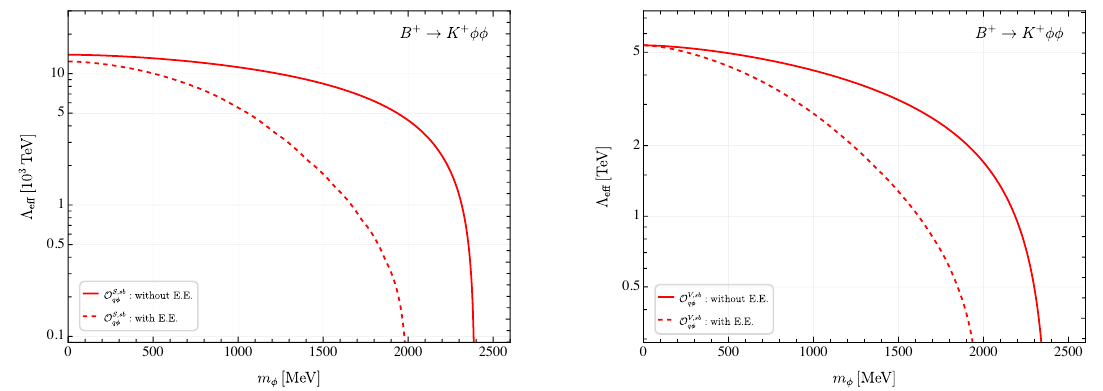
Figure 3 . Constraints on the effective new physics scale as a function of the DM mass m from the inclusive tag Belle II B + → K + ν ¯ ν search without (solid lines) and with (dashed lines) experimental efficiency (E.E.)